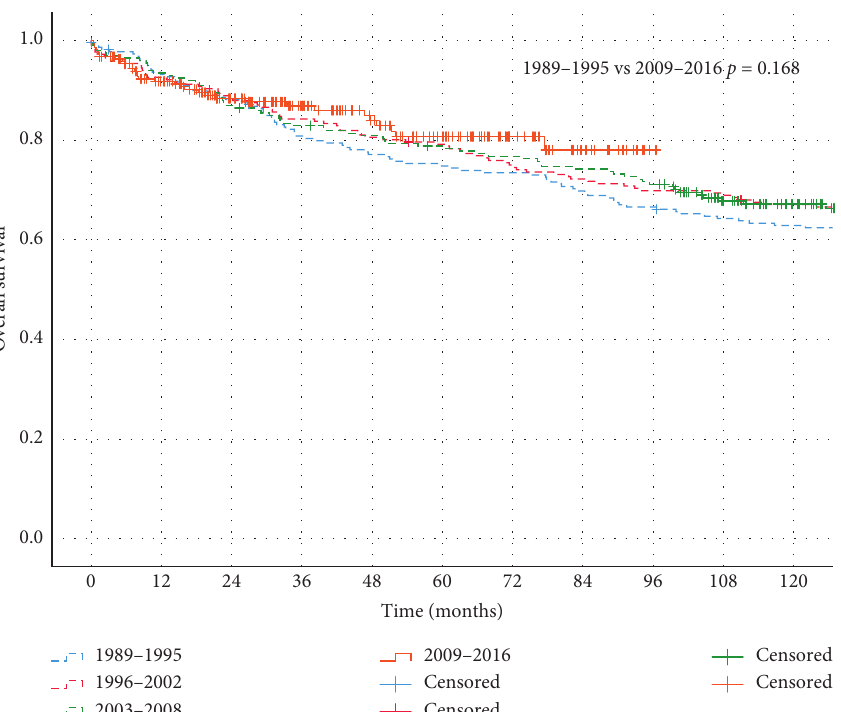
Figure 2: Kaplan–Meier curves representing OS of patients with primary localized disease divided in four groups by the period of diagnoses, as compared by the log-rank test ( p � 0 . 168).